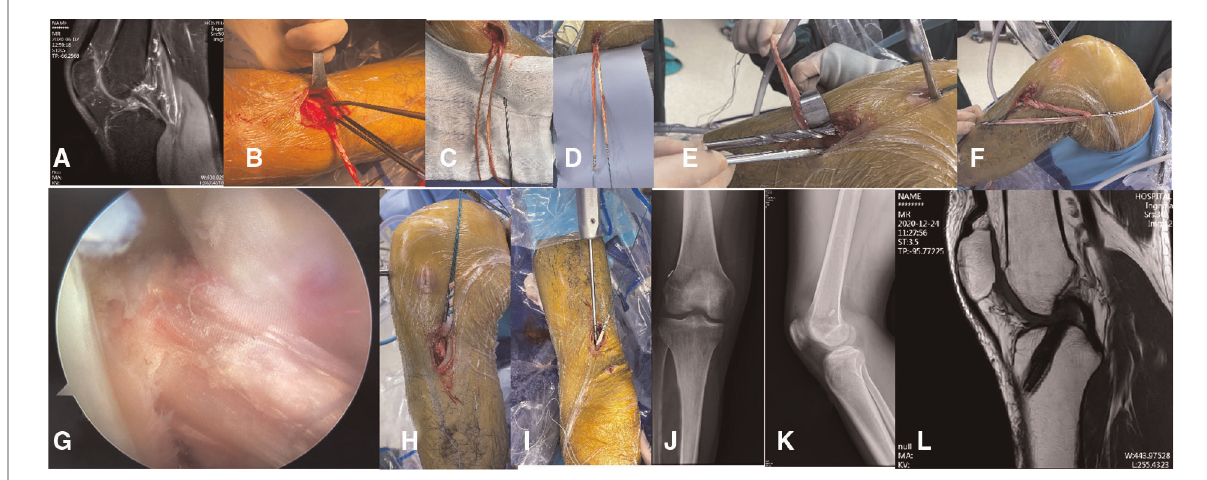
FIGURE 1 Observer patient D operation process. ( A ) Preoperative magnetic resonance imaging showed anterior cruciate ligament rupture. ( B ) The tibial insertion of the graft was preserved. ( C ) During the operation, tendon extractors with distal openings are used. ( D ) The graft is woven. ( E ) The stop of the graft is protected when the tibial tunnel is prepared. ( F ) The graft is estimated before it is placed. ( G ) With the help of arthroscopy, the grafts were observed to show good tension. ( H,I ) Interface screws were used to reinforce the graft. ( J,K ) Postoperative x-ray. ( L ) Postoperative magnetic resonance